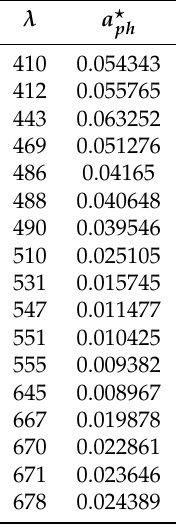
Table A10. Spectrally-dependent a (cid:63) MODIS, SeaWiFS, and